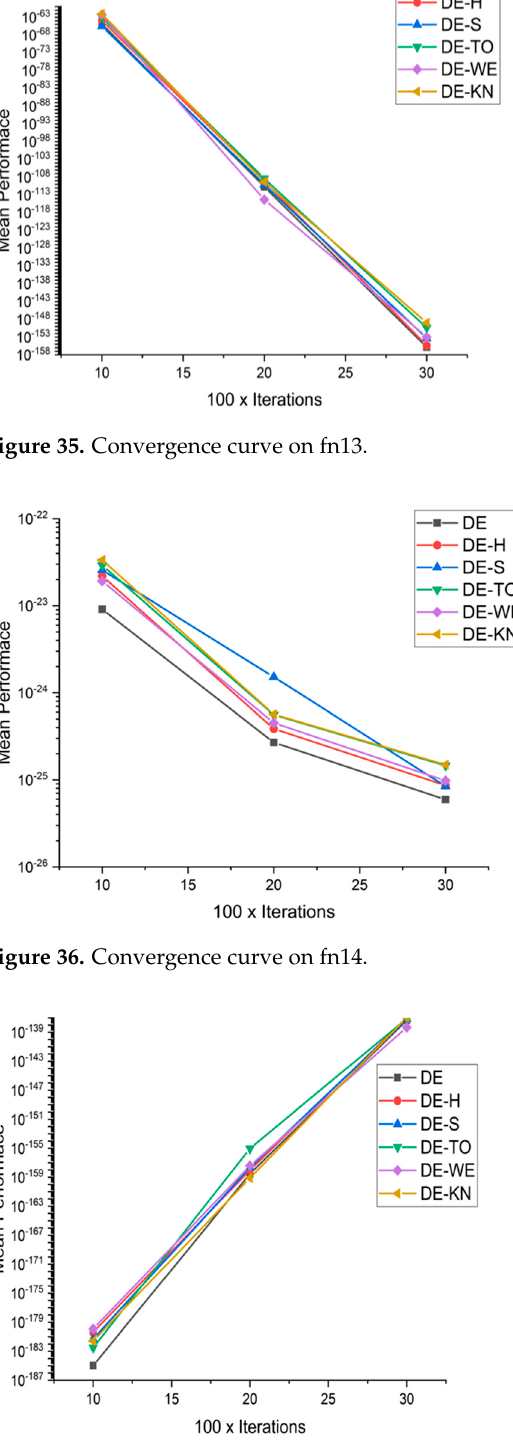
Figure 37. Convergence curve on fn15.